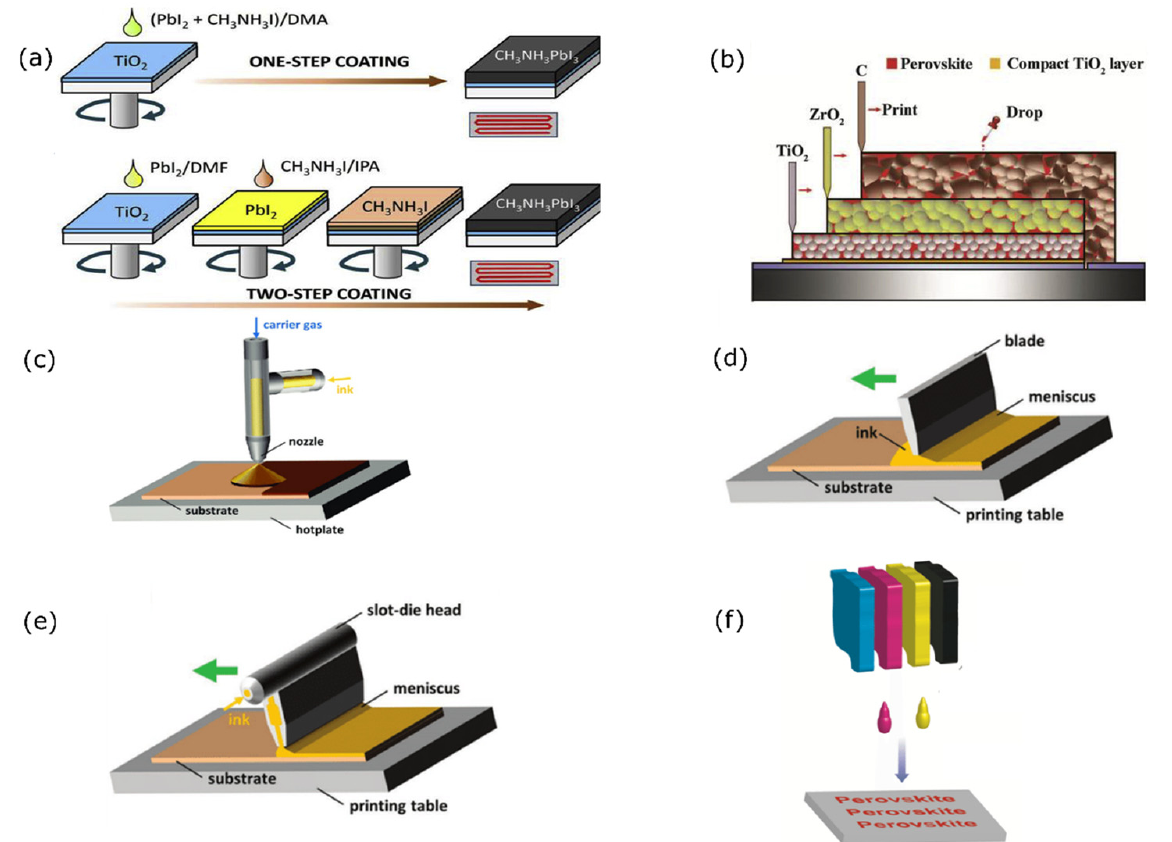
Figure 2. Different solution processing-based method for perovskite PV fabrication: ( a ) spin-coating [88], ( b ) drop-casting [88]. Reproduced with permission from Ref. [88]. Copyright 2017 Journal of Materiomics. ( c ) Spray-coating, ( d ) doctor blade, and ( e ) slot-die coating [89]. Reproduced with permission from Ref. [89]. Copyright 2019 Advanced Materials. ( f ) Ink-jet printing [90]. Reproduced with permission from Ref. [90]. Copyright 2016 Hal.